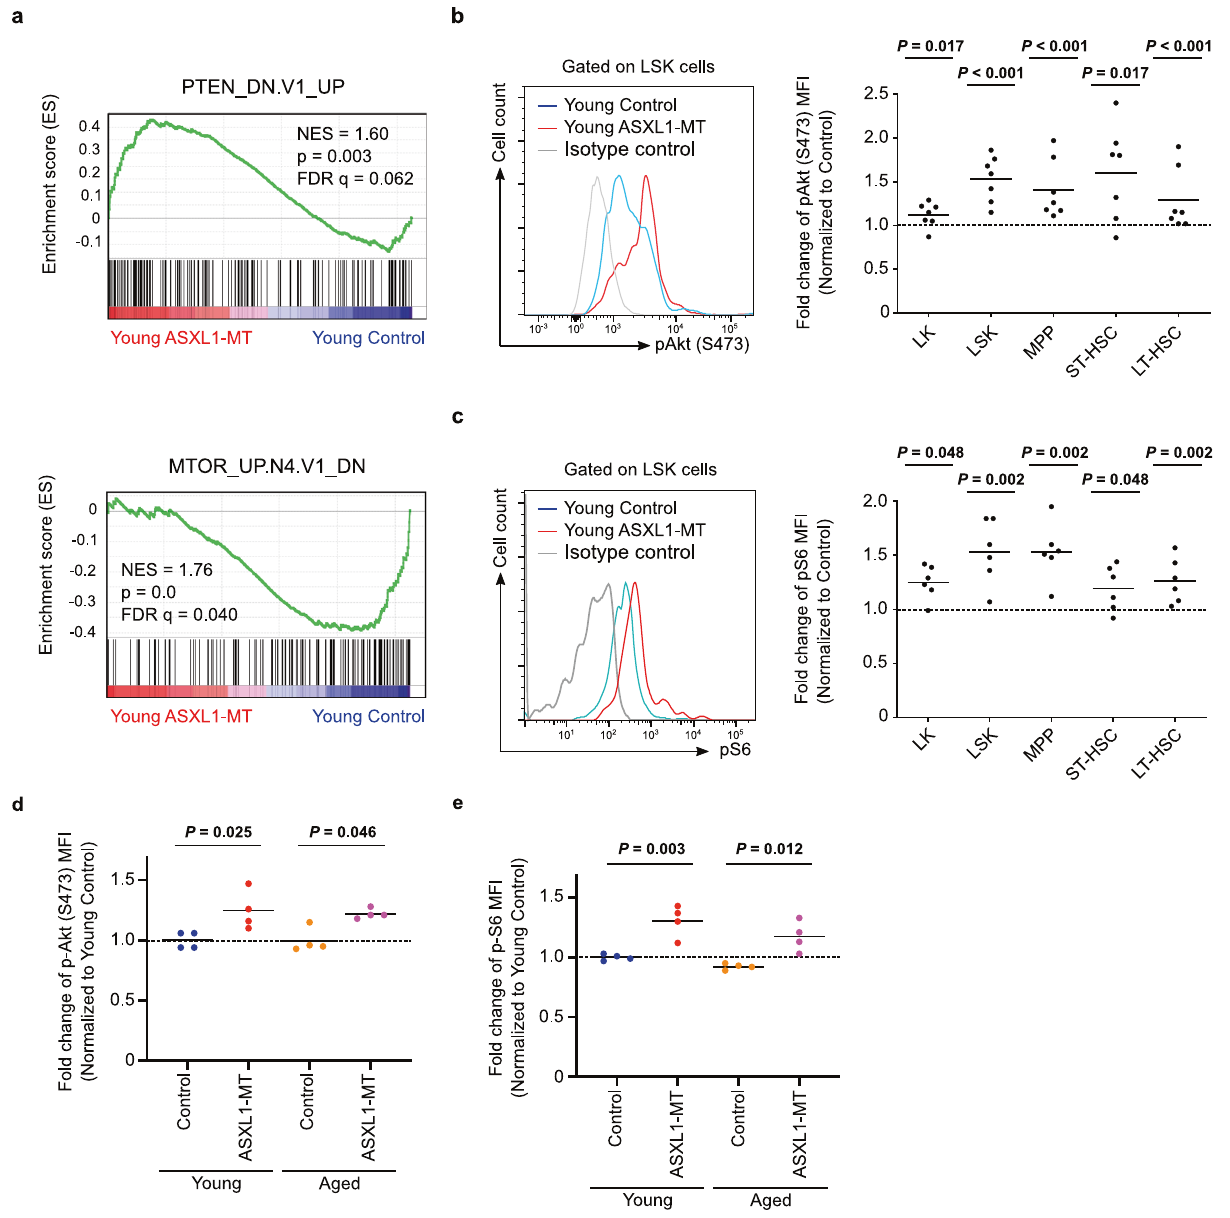
Fig. 4 ASXL1-MT activates Akt/mTOR pathway in both young and aged mice. a Gene set enrichment analysis of LSK cells from young Vav-Cre ASXL1- MT KI mice and littermate control mice using genesets up-regulated by PTEN de fi ciency (PTEN_DN.V1_UP) and negatively regulated by mTOR signaling (MTOR_UP.N4.V1_DN)( n = 3). b , c Levels of phosphorylated Akt (S473) ( b ) and phorphorylated S6 ( c ) in LK cells, LSK cells, MPPs, ST-HSCs and LT-HSCs from young Vav-Cre ASXL1-MT KI mice ( n = 7). Representative FACS plot (left panel) and summarized data (right panel) are shown. d , e Levels